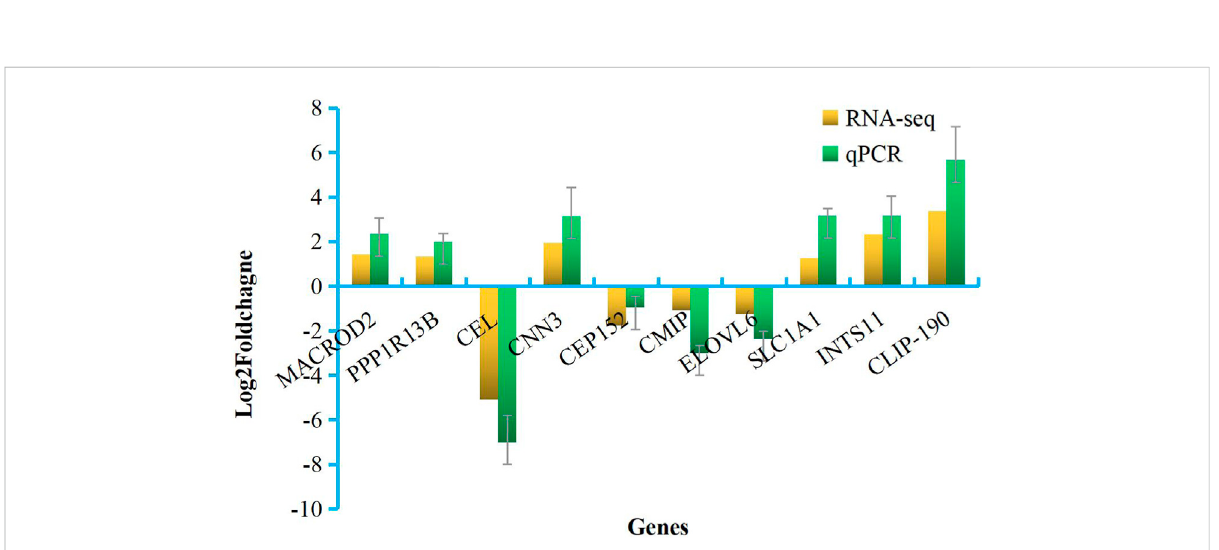
FIGURE 5 Validation of RNA-seq data by qPCR. X -axis, detected gene names; Y -axis, the relative expression level was expressed as log2 (fold change) in gene